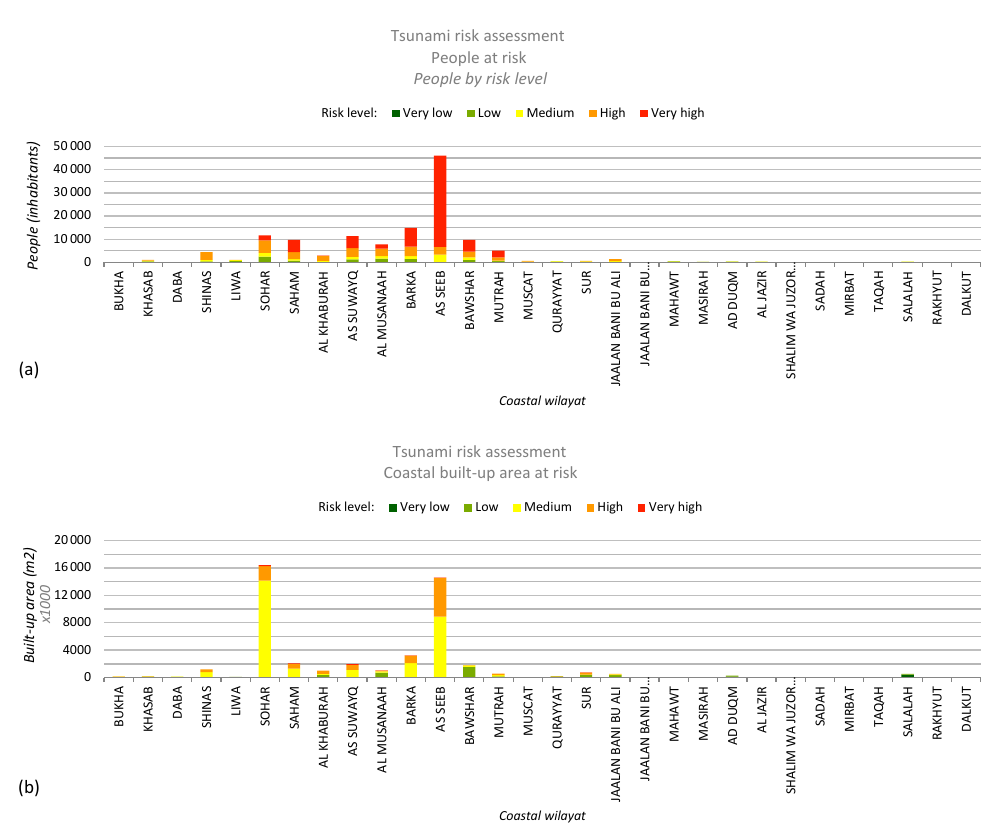
Figure 10. Population and built up areas by risk